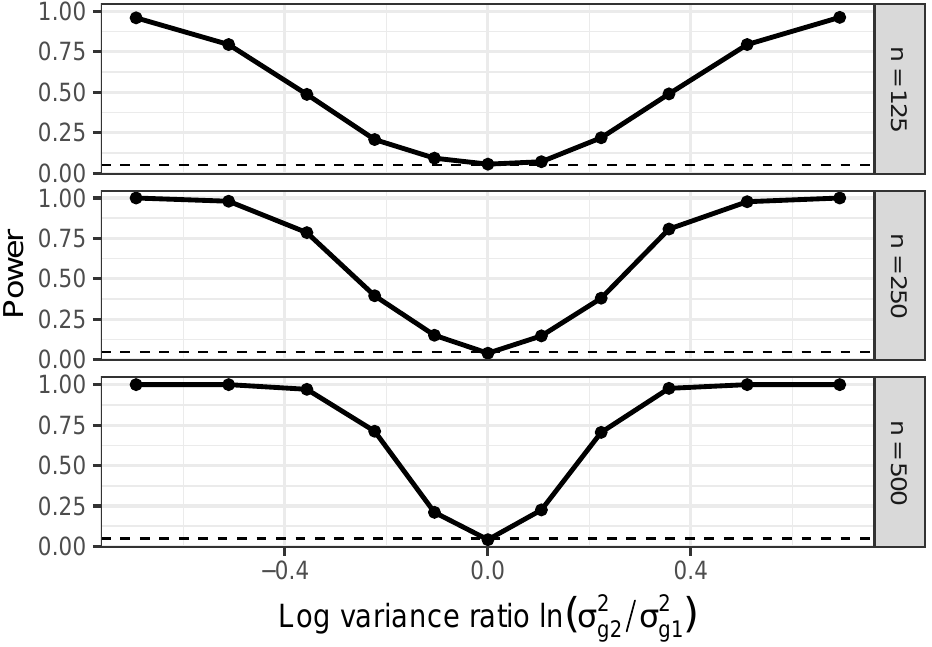
Figure 5. The power of IPC regression to detect a group difference in the error variance σ 2 . The dashed line marks a power of